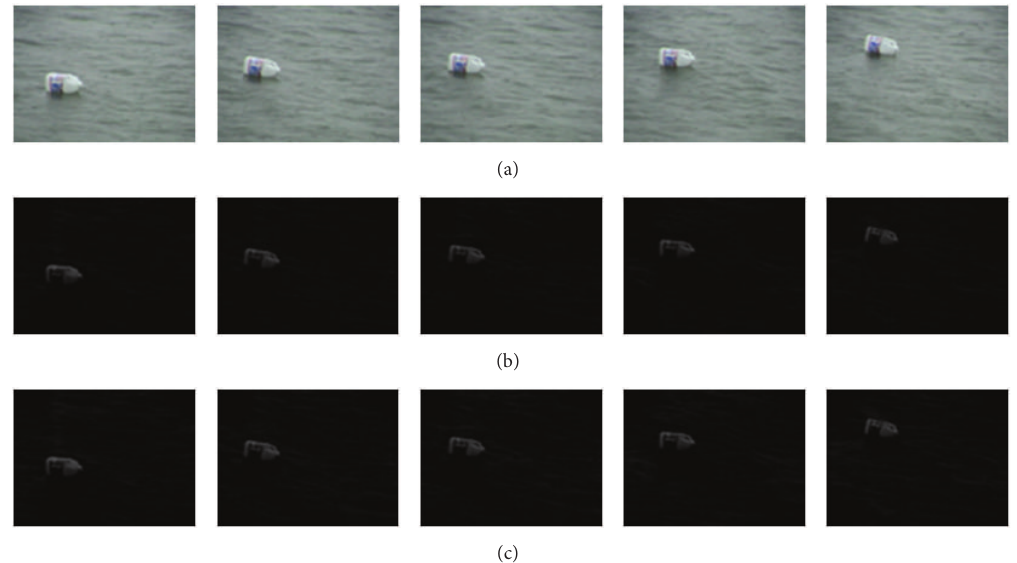
Figure 2: Background modeling. Top: original video sequence of a scene. Middle: foreground object recovered by MALM-TR. Bottom: foreground object recovered by RSTD [12]. The results are highlighted for both RSTD and